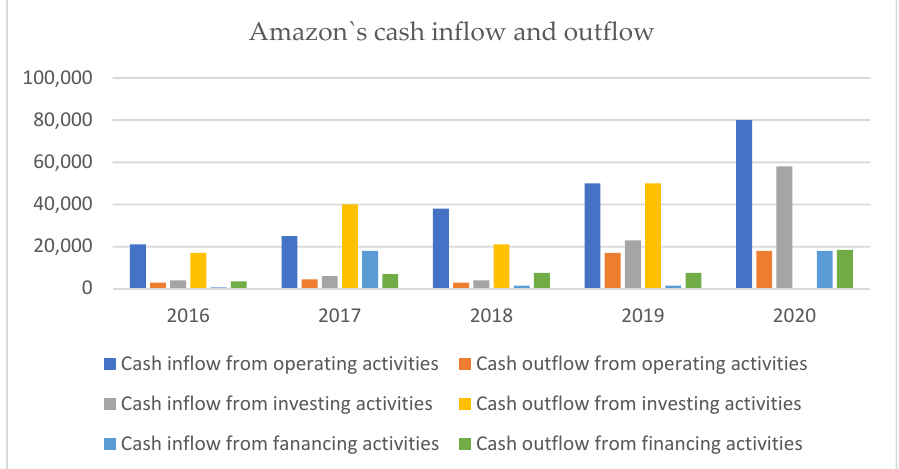
Figure 3. Amazon’s cash inflow and outflow.